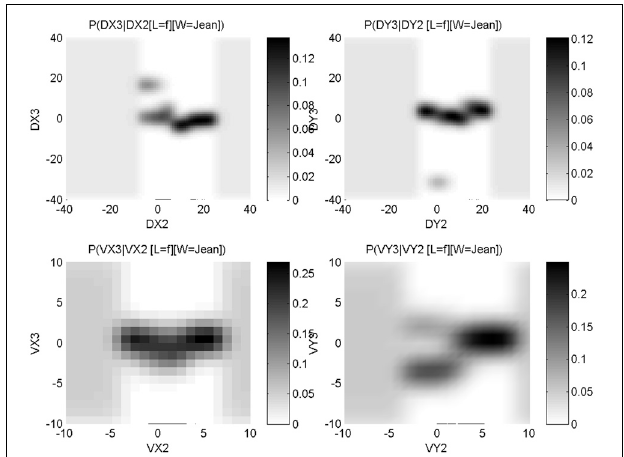
FIGURE 5 | Learned conditional probability distributions about x relative positions (top left panel), y relative positions (top right panel), x velocities (bottom left panel) and y velocities (bottom right panel), for the third via-point of letter “f.” Each panel shows a P(A | B) conditional probability distribution, with the conditioning variable B on the x -axis, the domain of variable A on the y -axis; in other words, each column is a probability distribution that sums to unity. Probability values correspond to gray-levels: the darker the color, the higher the probability. See main text for interpretation of the information encoded in these probability